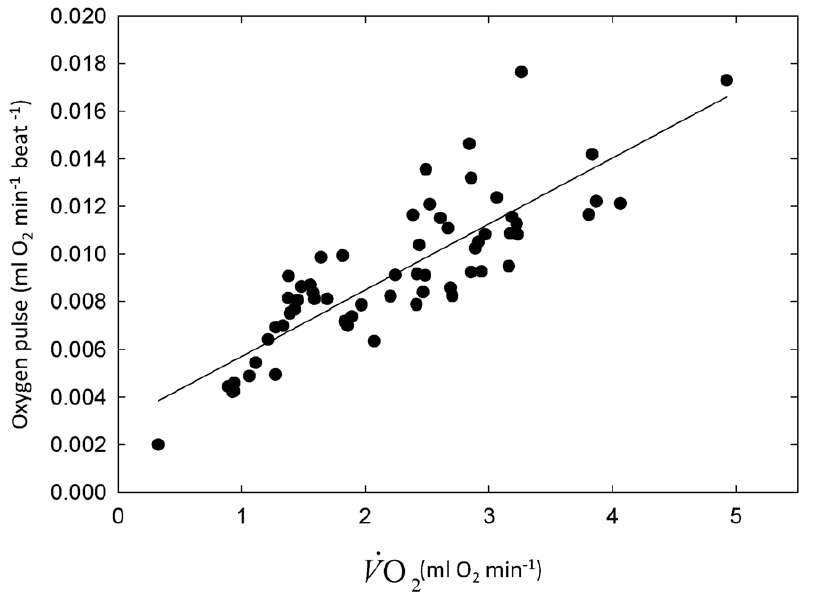
Figure 9. The relationship between _ VV O 2 and oxygen pulse (OP) in European bee-eaters for f H values , 350 beat min 2 1 .